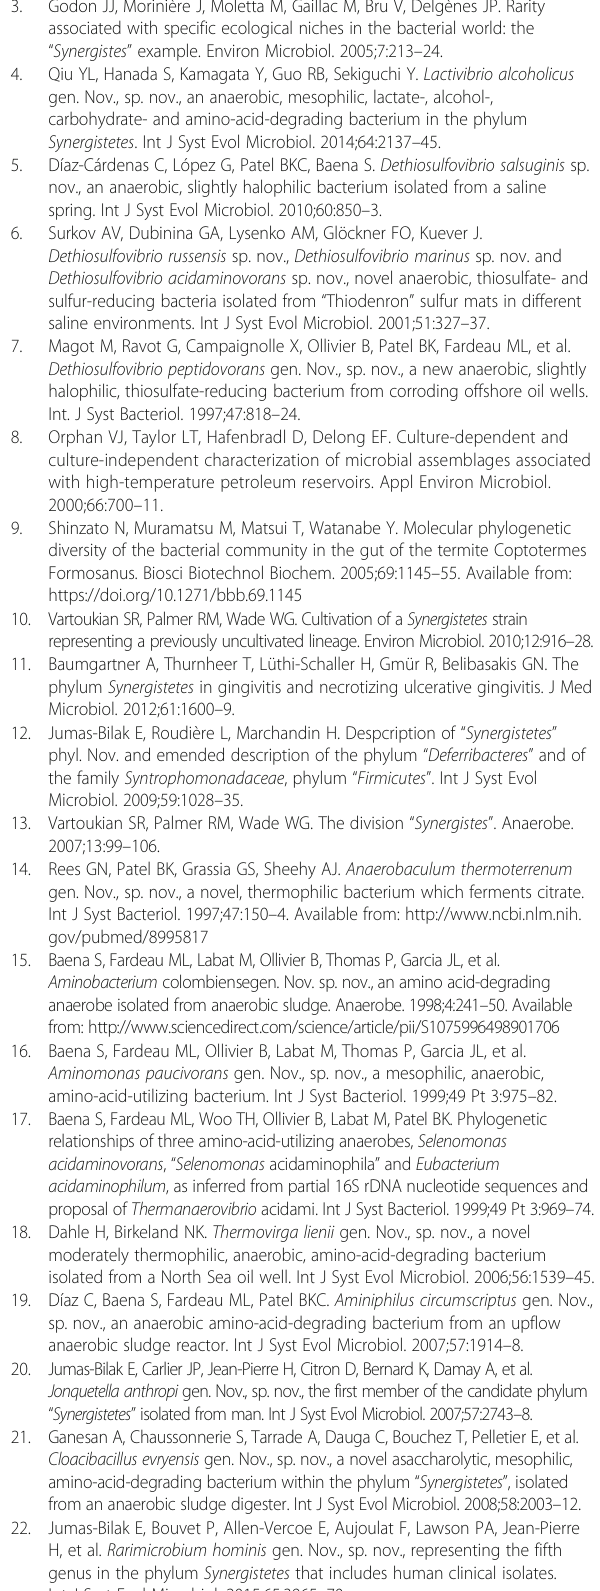
Additional file 8: Figure S8. Partial sequence alignment of the Hsp60 protein. The sequence alignment is showing the absence of 1 aa (red) in a conserved region that is mainly specific for atypical diderm taxa ( Negativicutes , ‘ Fusobacteria ’ , Synergistetes and ‘ Elusimicrobia ’ ) from all of the phyla of traditional Gram-negative bacteria that contain this insert. Only representative sequences from different bacterial phyla are shown here. Accession numbers of the non-redundant protein database are: Escherichia coli WP_077064857.1, Nostoc commune BAF95909.1, Helicobacter pylori